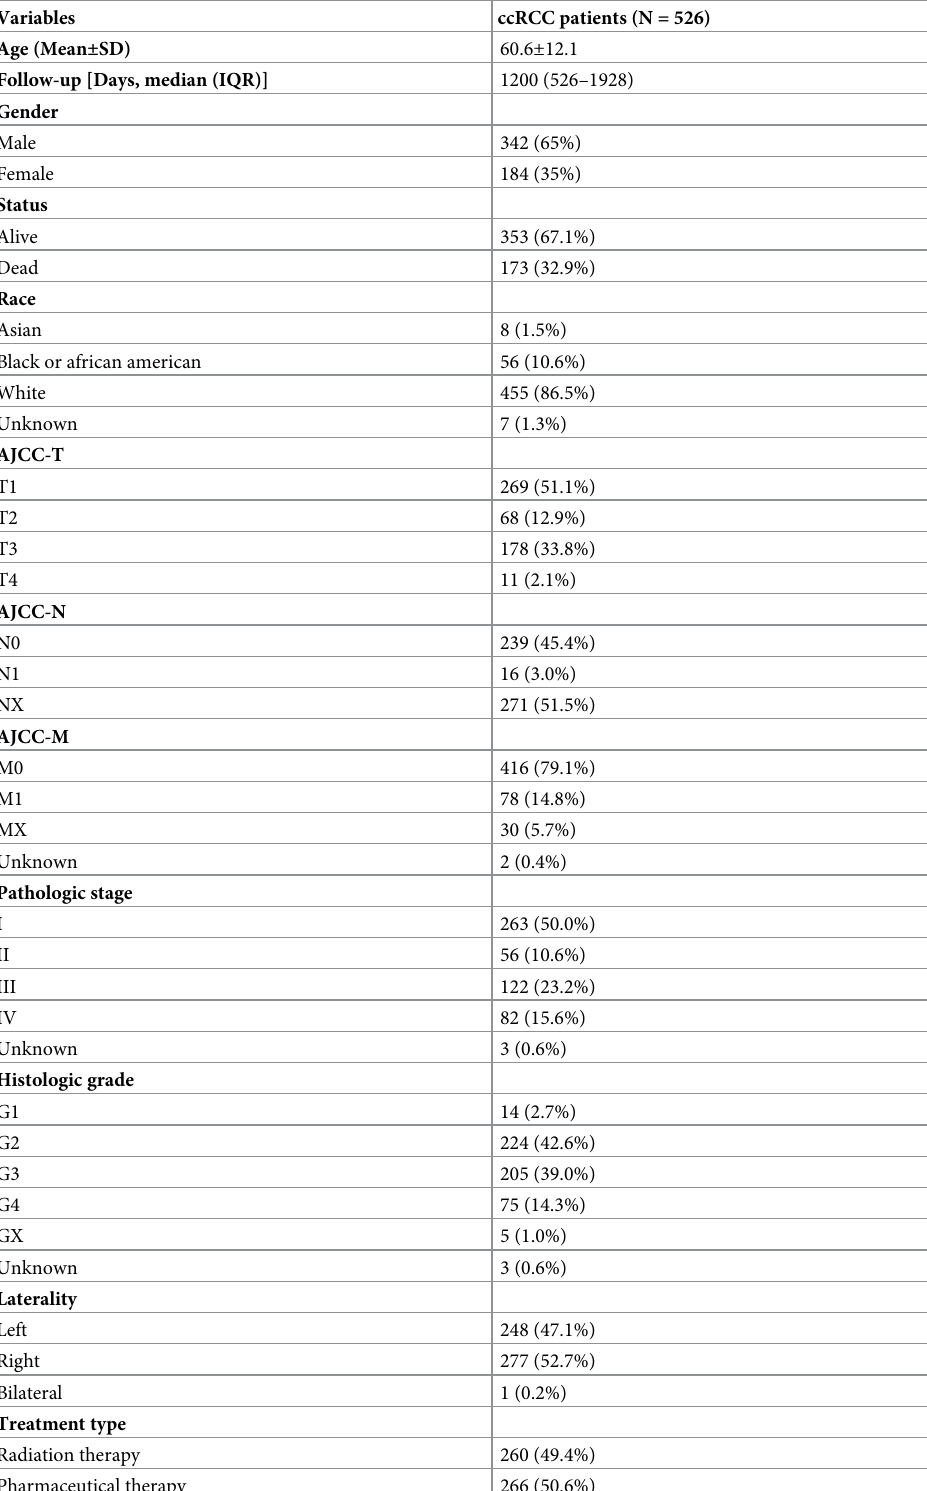
Table 3. Basic characteristics of 526 ccRCC